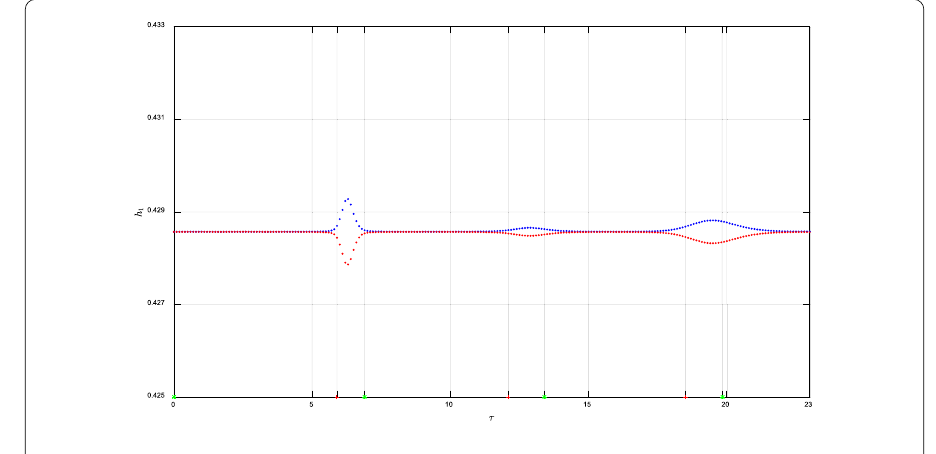
Figure 4 Bifurcation diagram of ring-structured patchy model (5.1) under case α > 0 and A < 0. The parameter values are κ = 1.8, μ = 0.3, ε = 1.1, n = 4, α = 0.6, d = 0.6, γ = 0.5